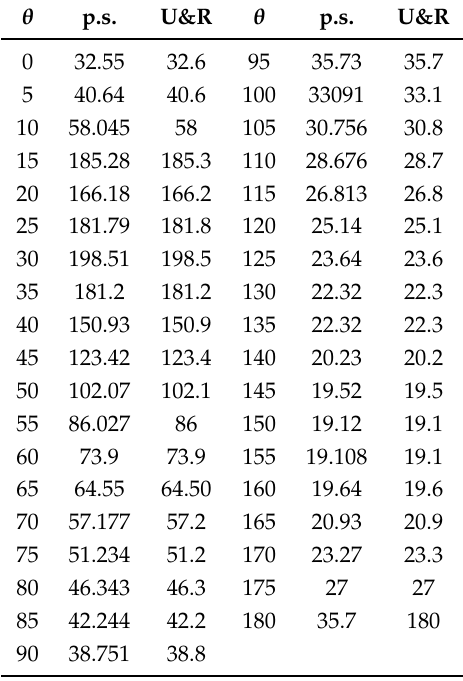
Table 2. Comparison of Tsai–Wu failure strength (MPa) obtained by present solution (p.s.) as well as those of Ukadgaonker and Rao [73] (U&R).